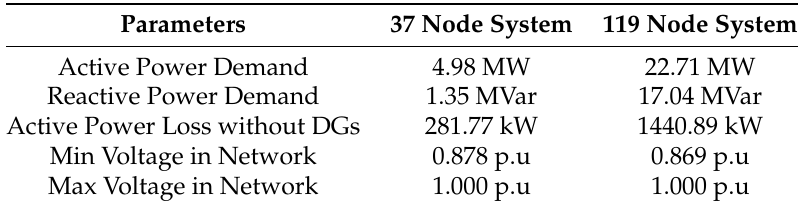
Figure 7. IEEE 119 node network. Table 1. Base case system